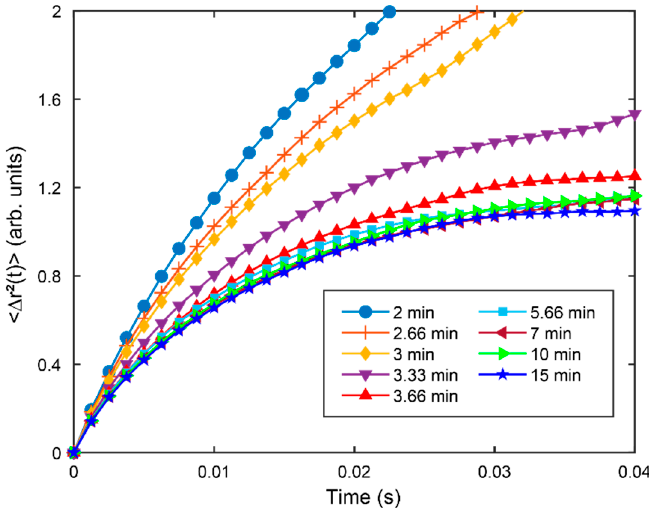
Figure 2. MSD curves of the optical vortex calculated at 2, 2.66, 3, 3.3, 3.66, 5.66, 7, 10, and 15 min during blood coagulation. It is obvious that the MSD curves decrease sequentially as the coagulation time proceeds, and the rate of decay slows down at the same time. A complete plateau level is reached after coagulation.